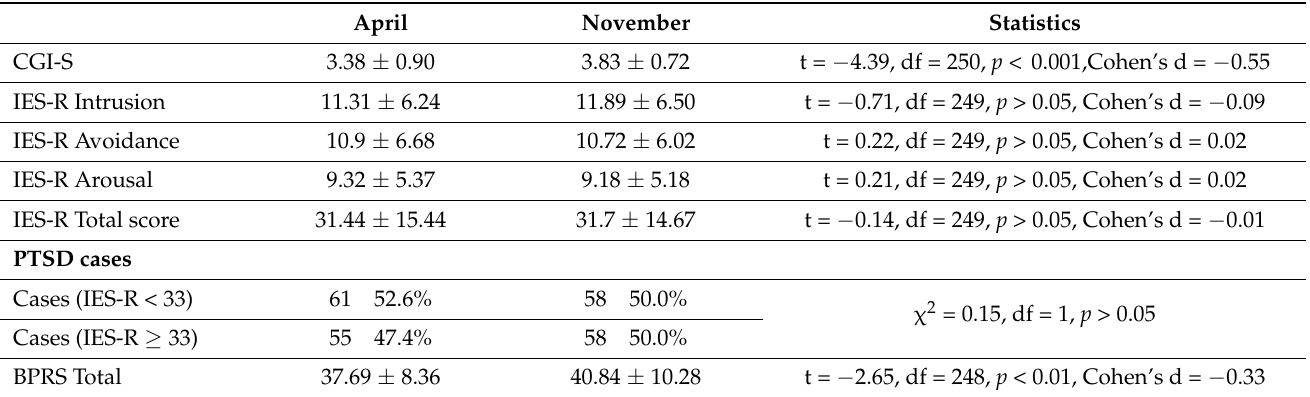
Table 2. Psychopathological dimensions and severity in subgroups.